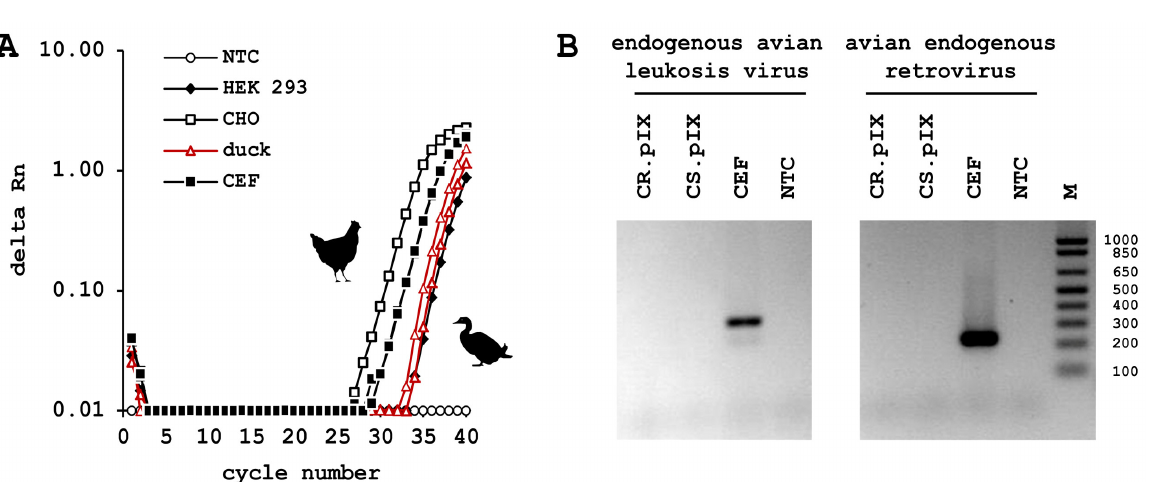
Figure 1. ( A ) Test on particle-associated reverse transcriptase activity in culture supernatant. Product Enhanced Reverse Transcriptase PCR (PERT-PCR) was performed with Brome mosaic virus RNA activated with primer 5 ′ -GCCTTTGAGAGTTACT CTTTG-3 ′ as tester, and primers 5 ′ -AAACACTGTACGGCACCCGCATT-3 ′ and 5 ′ -GCCTTTGAGAGTTACTCTTTG-3 ′ to amplify any cDNA that may have been generated by reverse transcriptases in the sample; ( B ) PCR against the chicken endogenous proviruses was performed with primers 5 ′ -TGGTGACCCCGACGTGAT-3 ′ and either 5 ′ -CCTATTTCCTTCTTAGAAGGAGA-3 ′ (EAV) or 5 ′ -CGATCTCCTTCCCGGAAGG AGT-3 ′ (ALV) as reverse primers. CS.pIX: cell line obtained from muscovy duck somites; NTC: non-template